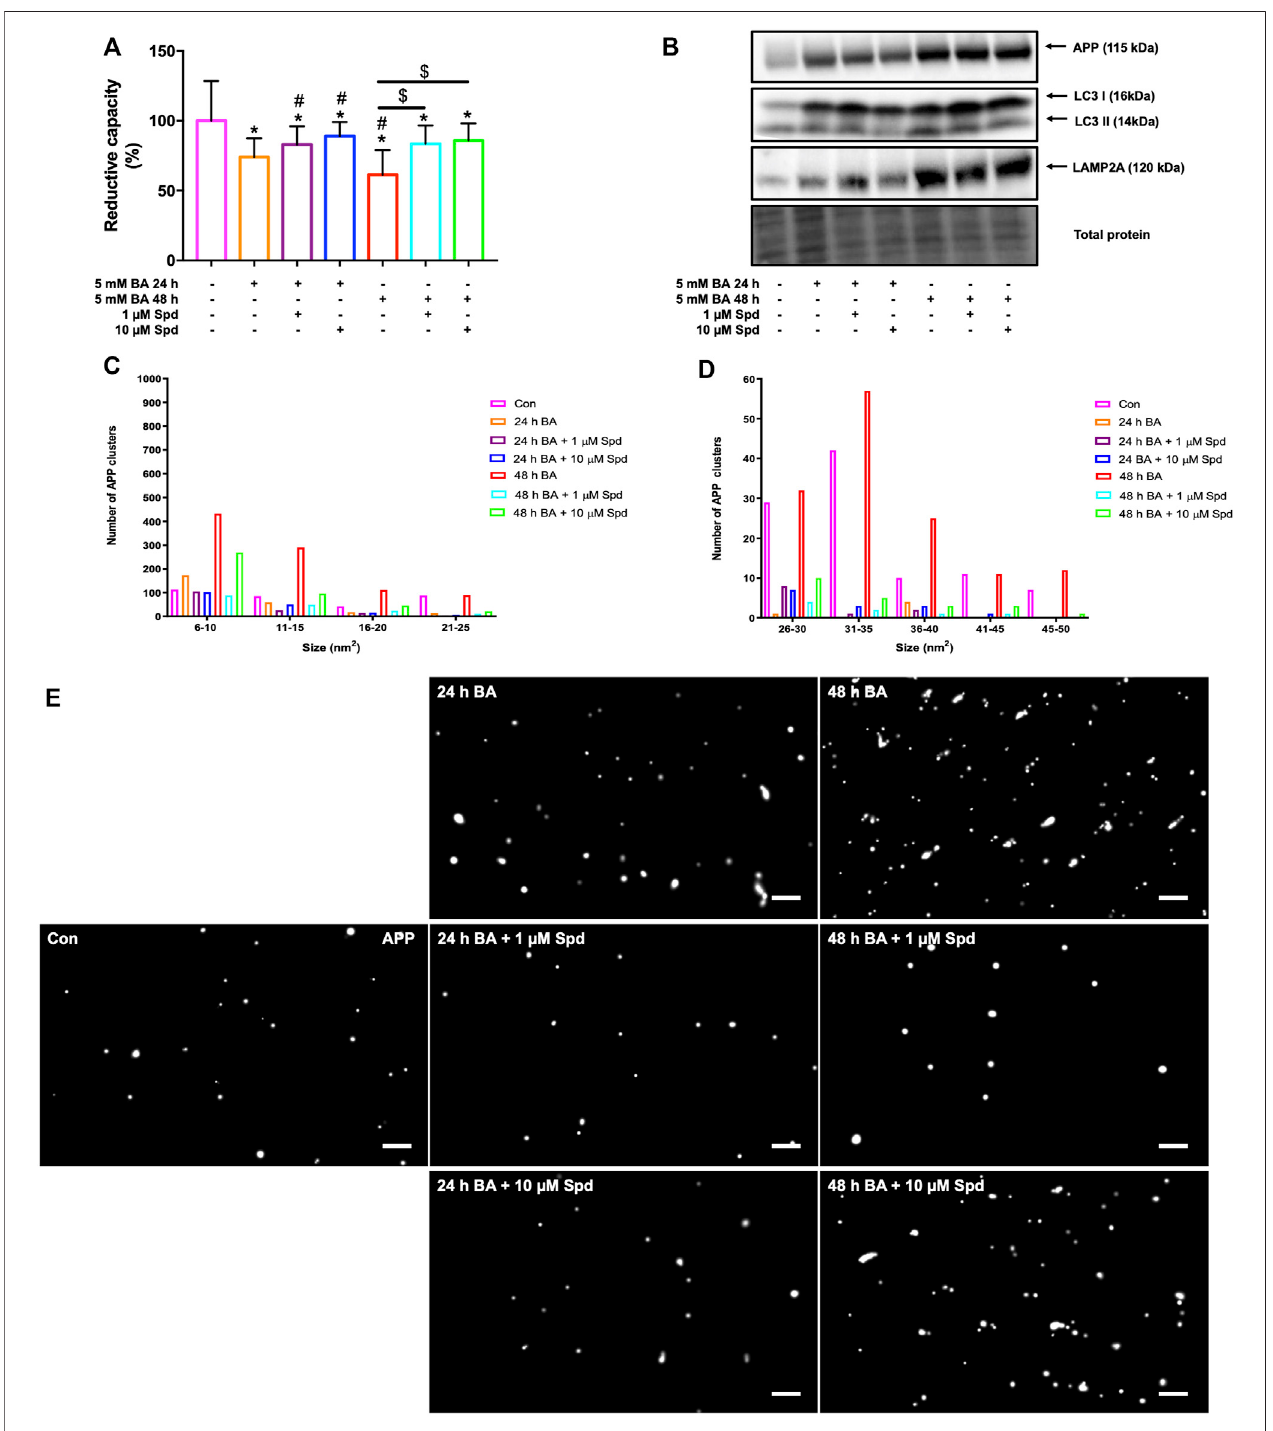
FIGURE 9 | Spermidine protects against APP-induced cytotoxicity and reduces the size and number of APP clusters. (A) Reductive capacity and (B) western blot analysis of APP, LC3-I/II and LAMP2A protein levels following treatment with a low and high concentration of spermidine in N2aSwe cells treated with BA overtime to overexpress APP ( n = 3). * = p < 0.05 vs. control, # = p < 0.05 vs. 24 h BA and $ = p < 0.05 vs. 48 h BA. (C – E) Size distribution of APP clusters and representative dSTORM micrographs in Gauss mode showing the localisation of APP clusters. Spermidine reduces the size and number of APP clusters. Scale bar: 0.5 μ m.